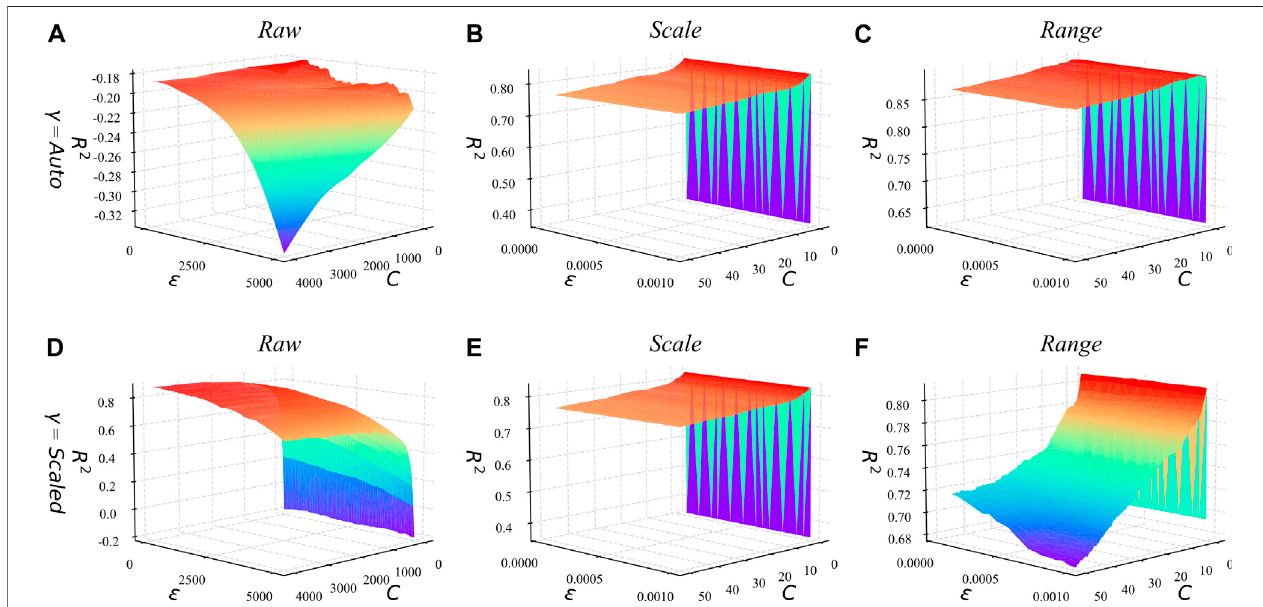
FIGURE4 | Grid search results ofSVR under different preprocess methods and different c . (A) is Raw & c (cid:1) Auto , (B) is Scale & c (cid:1) Auto , (C) is Range & c (cid:1) Auto , (E) is Raw & c (cid:1) Scaled , (F) is Scale & c (cid:1) Scaled , (G) is Range & c (cid:1) Scaled .